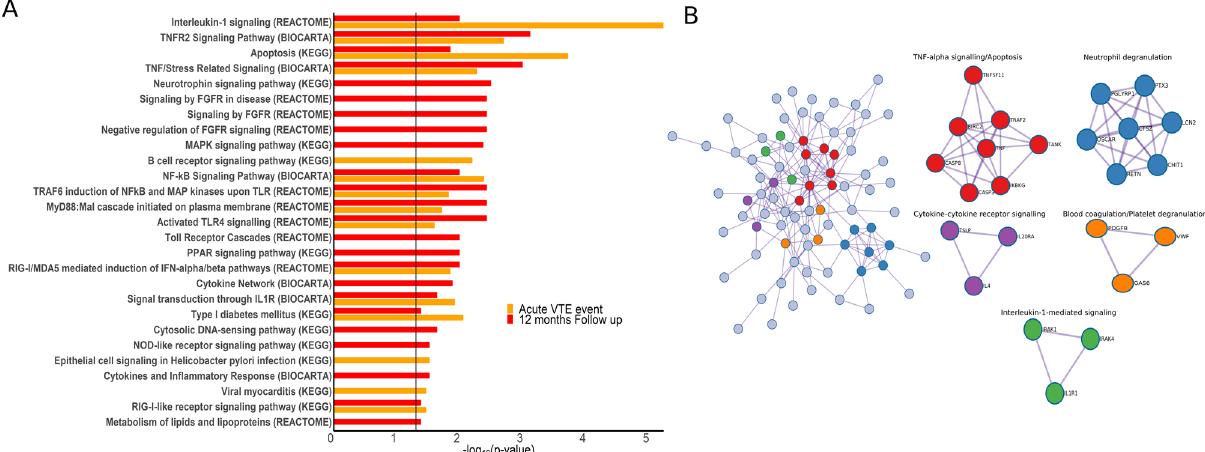
Figure 4. Shared and specific enriched pathways of FXI:C related proteins in the acute VTE event and 12 months follow up ( A ), and protein–protein interaction networks of proteins included in both models ( B ). This figure shows the shared and specific enriched pathways related with FXI:C associated proteins ( A ). The vertical black line depicts the cut-off ( p -value < 0.05). Orange and red lines depict the p -value of a pathway in the acute event and 12 months follow up, respectively. Panel B shows the protein–protein interaction enrichment analysis where only physical interactions are depicted. Networks with 3 or more proteins (densely connected nodes) were color coded and labeled with a functional term based on a Gene Ontology enrichment analysis (https:// metas cape.